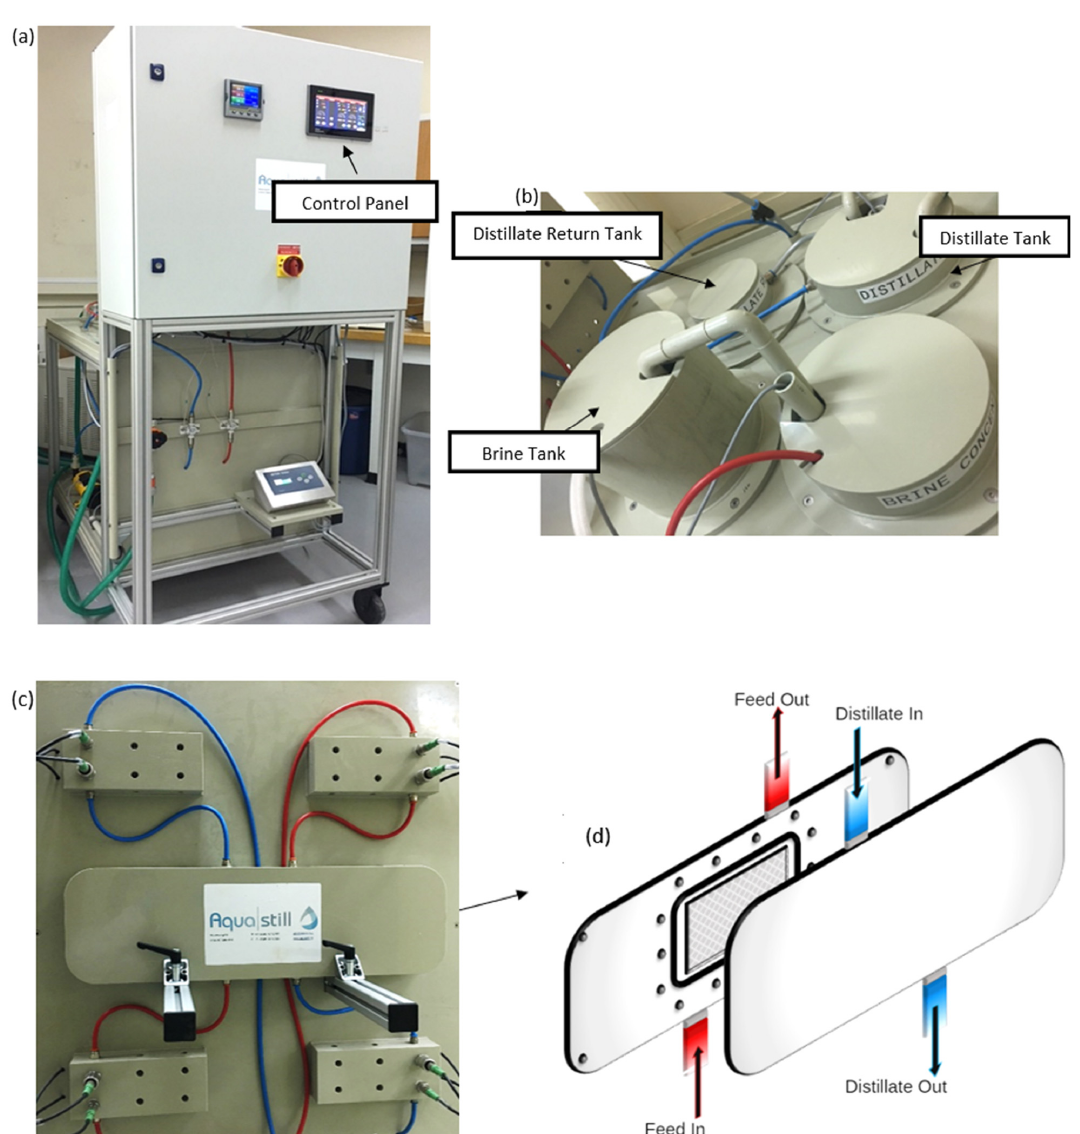
Figure 1. ( a ) Front side of the DCMD pilot unit at Qatar University labs, ( b ) the tanks on the backside of the pilot unit ( c ) Membrane channels from the back side of the pilot unit, and ( d ) 3D illustration of DCMD membrane holder showing counter current flows in the DCMD pilot unit.